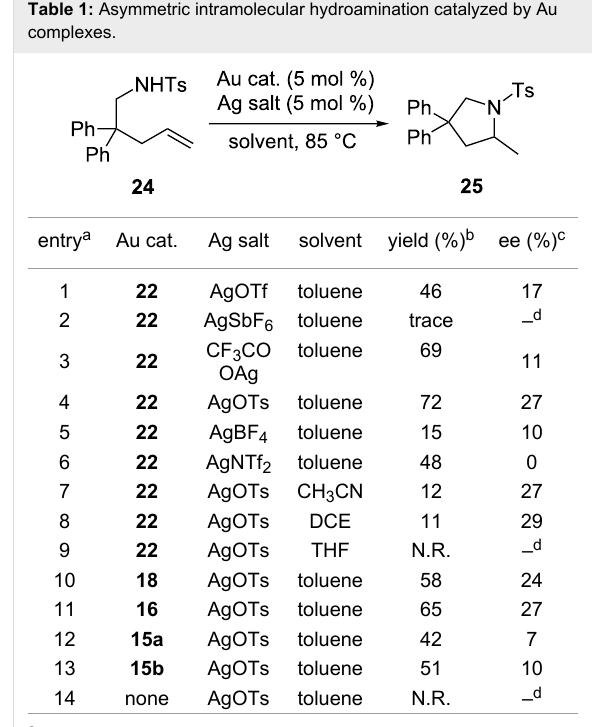
Table 1: Asymmetric intramolecular hydroamination catalyzed by Au complexes.